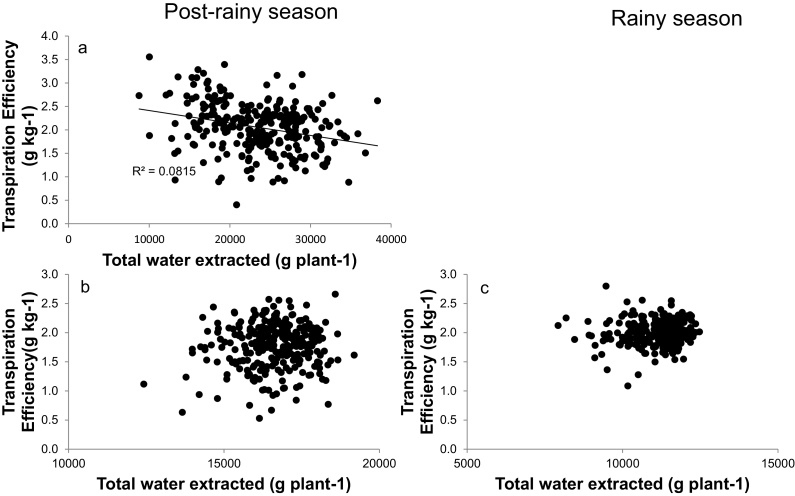
Relationships between the total water extracted and transpiration efficiency in the post-rainy season (a, b) and the rainy season(c), under well-watered (a) and water stress (b, c) conditions. Data are means of three replicated plants per genotype and treatment in the post-rainy season and four replicated plants per treatment in the rainy season.